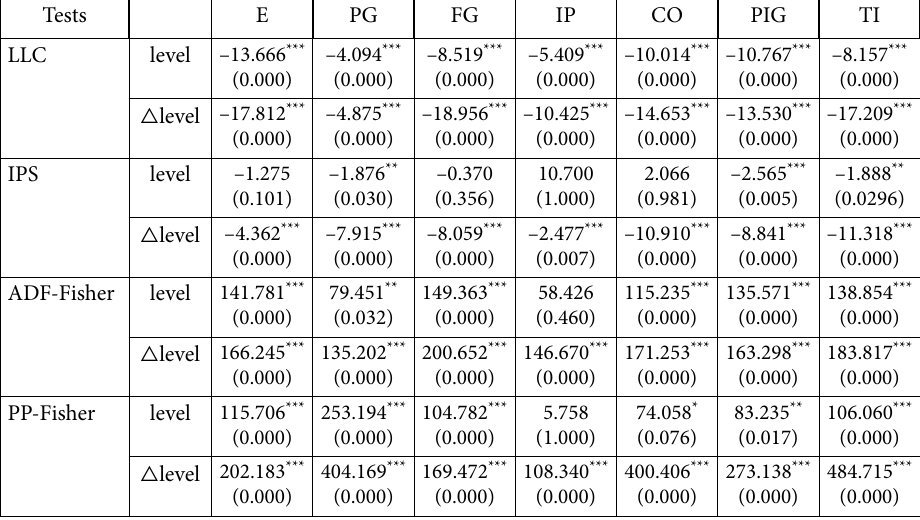
Table 7. The results of unit root tests